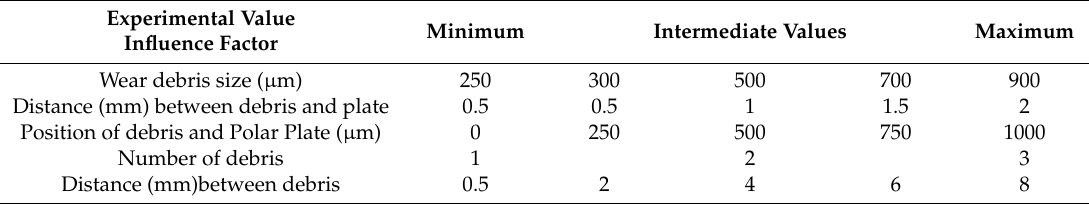
Table 1. Value of influence variables for simulation